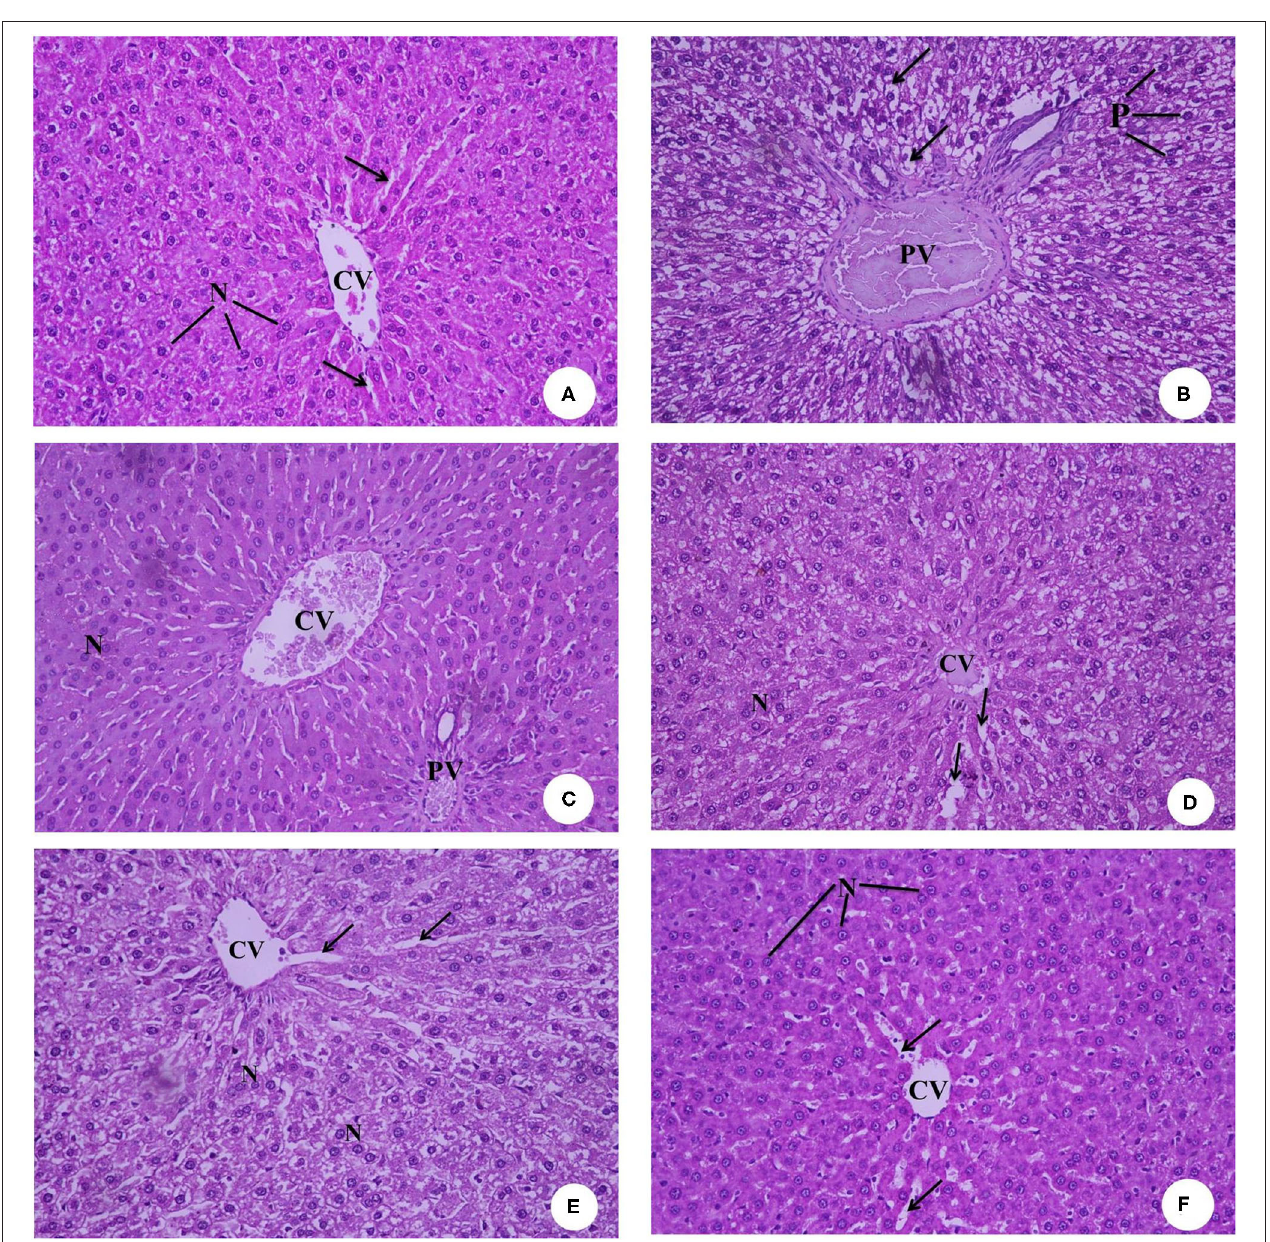
FIGURE 7 | means of duplicates ± SD. Serum profile data with different letters are significantly different ( p ≤ 0.05). G1, Negative control; G2, Positive control Group; G3, Fed SFY fortified with free Fe + ascorbic acid; G4, Fed SFY fortified with free Fe + FA + ascorbic acid; G5, Fed SFY fortified with Fe@ BSA-NPs + ascorbic acid; G6, Fed SFY fortified with Fe + FA@ BSA-NPs + ascorbic acid. RBCs (10 6 µ L − 1 ), WBCs (10 3 µ L − 1 ), Hb (g dL − 1 ), Platelets ( µ m 3 ); TIBC, Total iron-binding capacity; TS, Transferrin saturation; BSA-NPs, Bovine Serum Albumin nanoparticles; FA, Folic Acid.